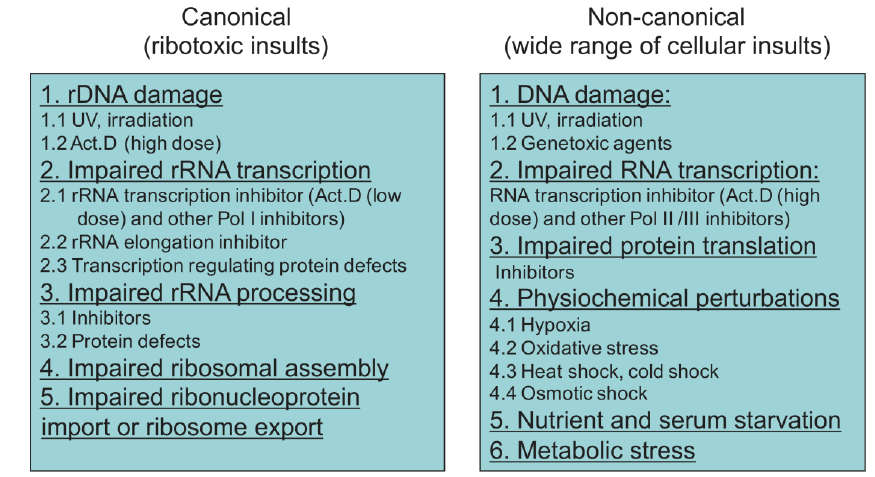
FIGURE 2: Stressors eliciting nu- cleolar stress . Two categories of nucleolar stress inducers are direct ribotoxic insults and a wide range of cellular